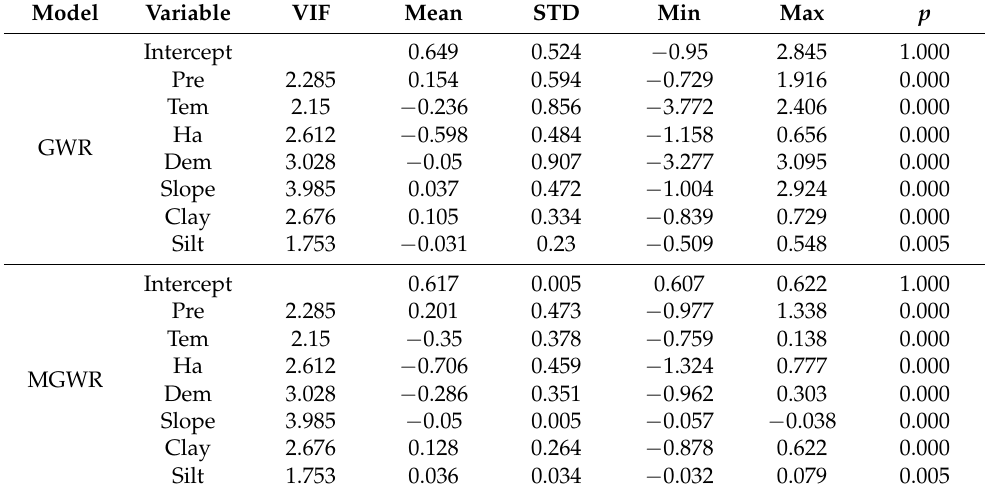
Table 3. Comparison of parameter estimate and testing result for GWR and MGWR. The explanatory variables including precipitation (Pre), temperature (Tem), elevation (Dem), gradient (Slope) and human activity